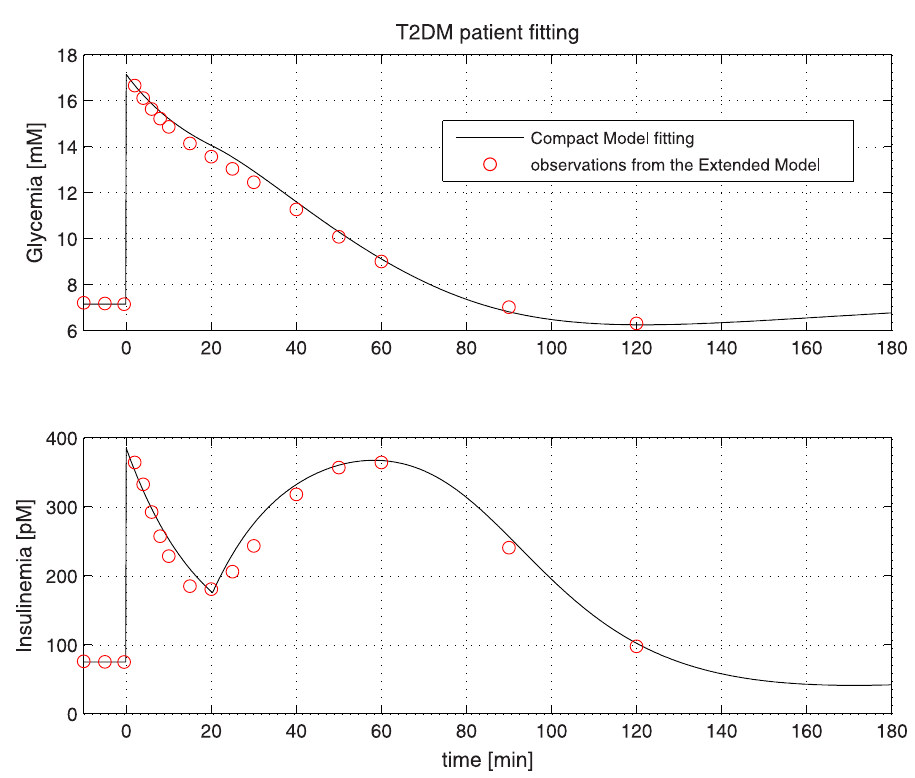
Fig 6. Observations extracted from a virtual T2DM patient undergone an IVGTT (red dots). The black line represents the Compact Model fitting.